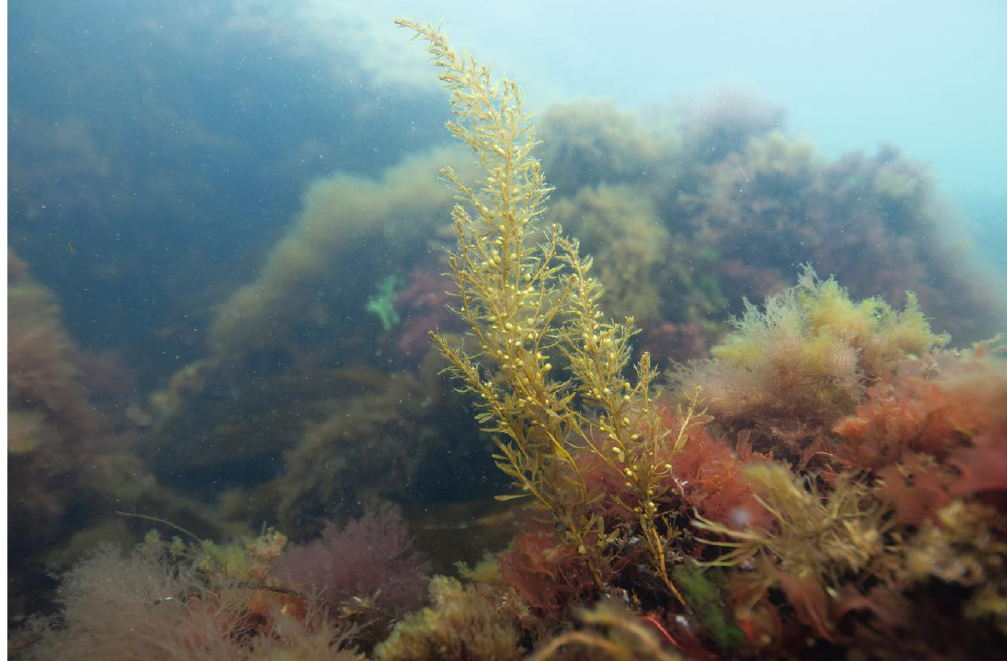
Figure 16. Sargassum muticum on boulder reef (Marselisborg Harbor) Photo: P. Bondo Christensen. In Denmark, Sargassum muticum is established in areas with salinities above 16 psu and medium exposure. The species tolerates low light and a range in temperatures and expands in Denmark with an average speed of 7–8 km (up to 22.4 km) per year [137]. Expansion is limited by suitable hard substratum and reduced salinity toward the Baltic Sea.